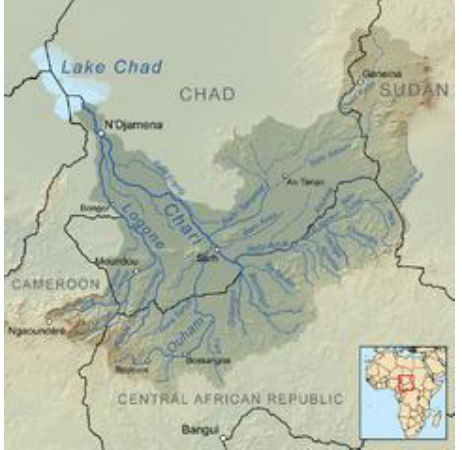
Figure: 2 Locations of Chari and Logone Rivers In the Chad